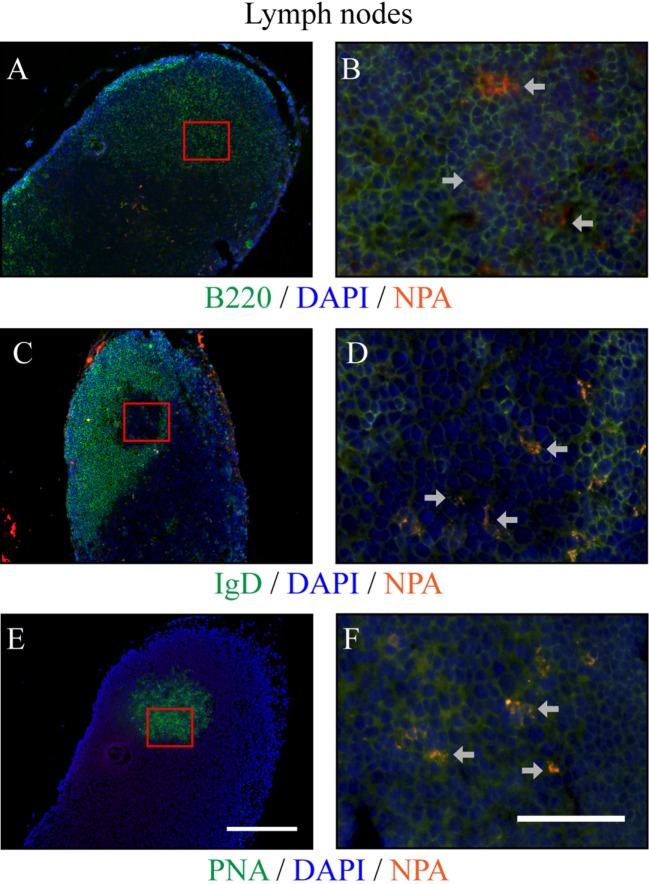
NPAs can be found in germinal centers from draining lymph nodes of mice with lupus-like disease induced by NPA-immunizations. The NPAs (identified with the monoclonal antibody H308, red fluorescence) were assessed in a series of double stainings with H308 and anti-B220 (green fluorescence) (A,B), or with H308 and anti-IgD (green fluorescence) (C,D), or with H308 and PNA (green fluorescence) (E,F), in serial tissue sections from the draining inguinal lymph nodes of mice that developed the lupus-like disease. B cell follicles can be identified in situ with B220 [(A,B), green fluorescence]. A negative IgD area [(C,D), green fluorescence] inside B cell follicles indicates the germinal center; and this same IgD-negative zone corresponds to the PNA-positive labeling in the contiguous section [(E,F), green fluorescence]. Nuclei counter-staining was done with DAPI (blue fluorescence). Germinal centers were distributed along the tissues and NPA staining revealed the positive cells in germinal centers (arrows). Representative pictures of three independent experiments are shown. For each marker, the images to the right (40×, scale bar = 50 μm) correspond to the red squares indicated on the images to the left (10×, scale bar = 200 μm). Co-localization of a given marker (green fluorescence) with NPA (red fluorescence) appears as orange-yellow. Images with individual colors are shown in Figure S2 in Supplementary Material.